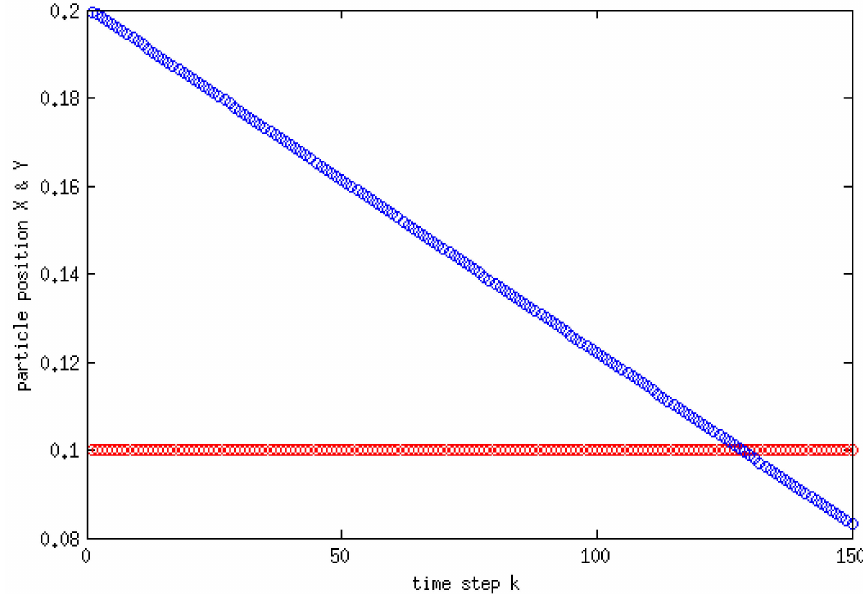
Figure 13. x (red) and y (blue) positions of the particle with time.